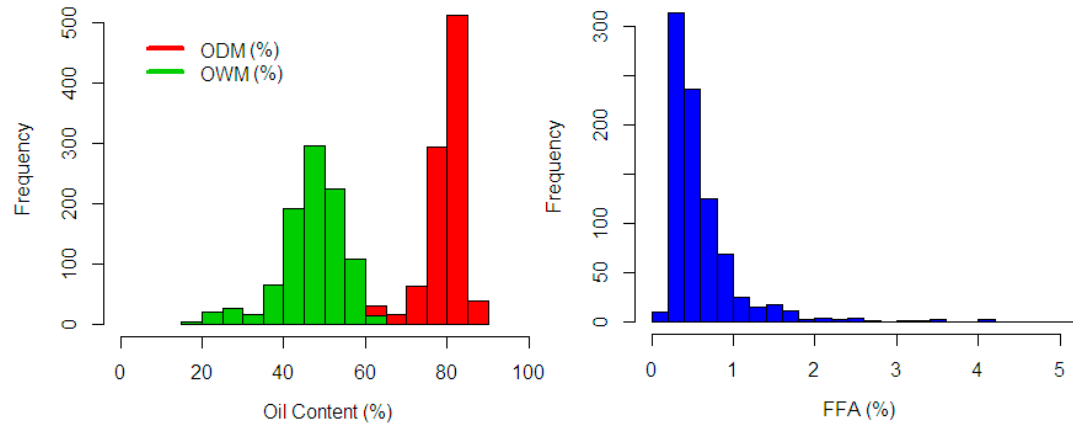
Figure 6. Frequency distribution on response variable: %ODM (red), %OWM (green), and %FFA blue).